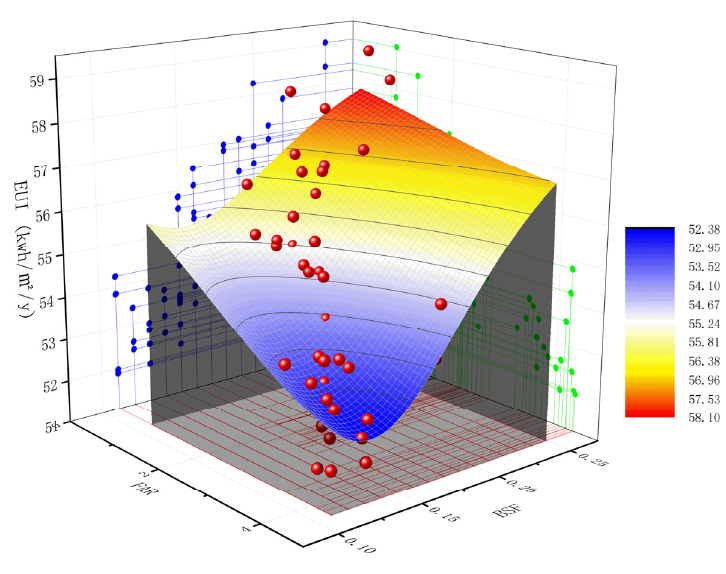
Figure 21. 3D nonlinear surface for multiple regression equation .